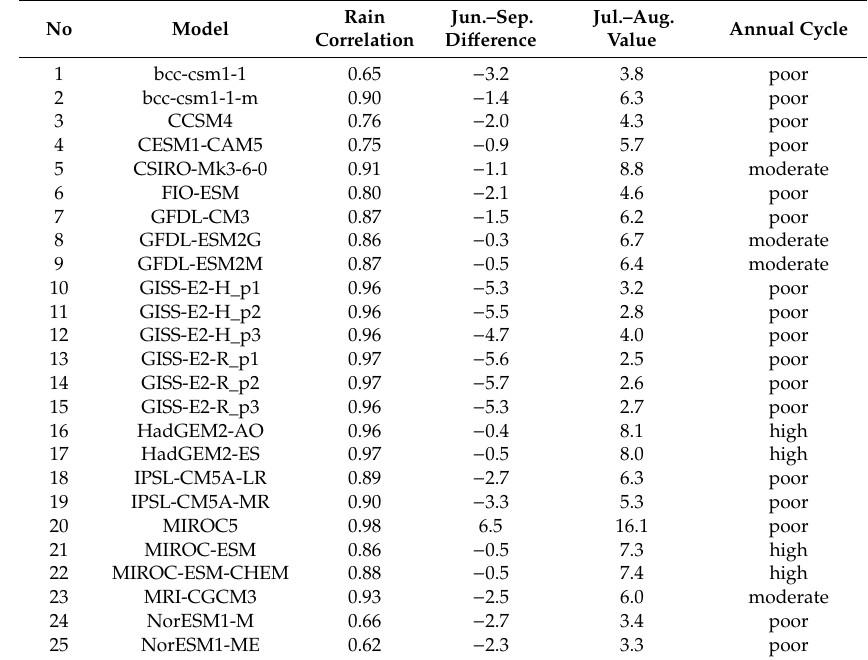
Table A1. Evaluation of NW-Ethiopia highlands CMIP5 model rainfall with gauge-interpolated reference [65] 1981–2010. Correlation of mean annual cycle, Jun.–Sep. seasonal difference between observation and model, model mean mid-summer rain rate (mm / day) and phase / amplitude ‘fit’ of annual cycle.